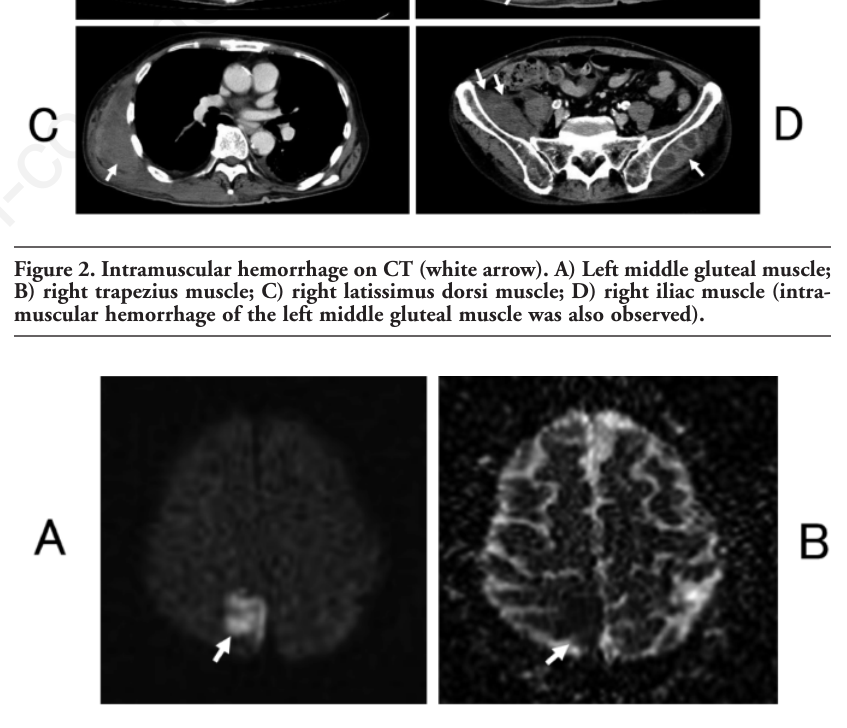
Figure 3. Brain MRI. A) A diffusion-weighted image showed a high-signal-intensity lesion in the right parietal lobe. B) An apparent diffusion coefficient (ADC) map indicat- ed a low-signal-intensity lesion, suggesting the new onset of cerebral